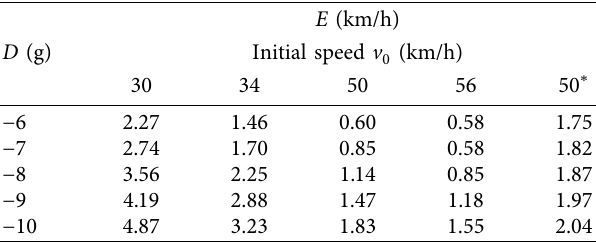
Table 22: Errors in the speed changes obtained via the traditional ACN algorithm.